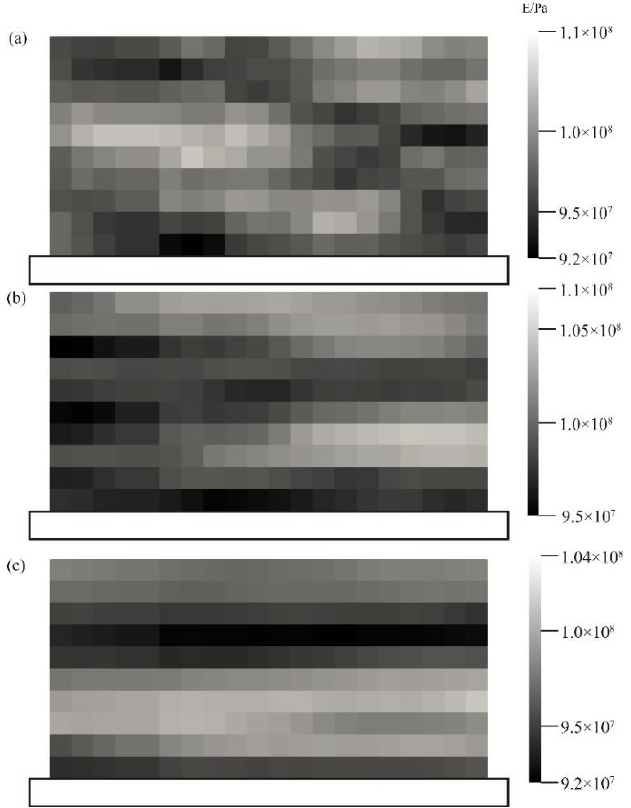
Figure 16. Realisations of the random field for different horizontal scales of fluctuation ( a ) 4.0 m, ( b ) 10.0 m and ( c ) 20.0 m.